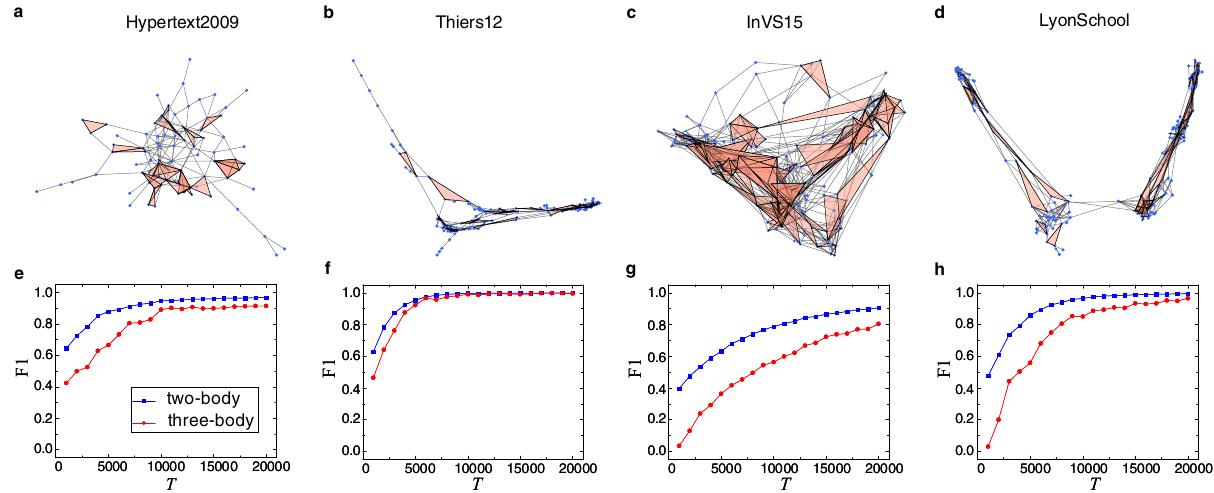
Fig. 2 Visualization and reconstruction performance for real-world 2-simplicial complexes. Visualization results for ( a ) Hypertext2009, ( b ) Thiers12, ( c ) InVS15, and ( d ) LyonSchool. The corresponding reconstruction performances are shown in panels ( e – h ) in terms of F1 score versus the length T of the available time series. The blue squares and red circles demonstrate the reconstruction performance of two-body and three-body connections, respectively. Parameter values are α = 0.3, ω = 1, ρ 0 = 0.2, and μ = 1. Each data point is the result of averaging over fi ve